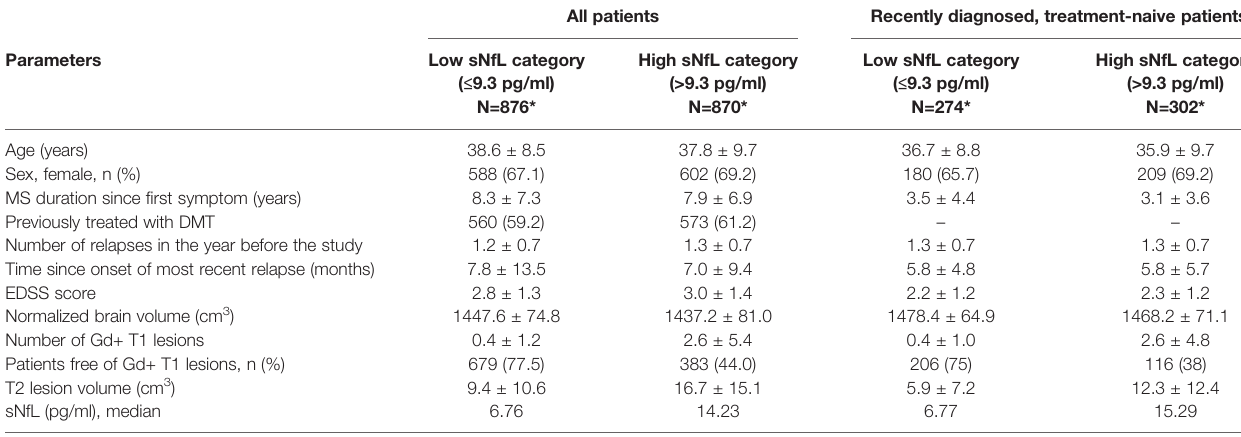
TABLE 1 | Demographics and baseline characteristics in the overall study population, and in the subgroup of recently diagnosed, treatment-naive patients, by sNfL baseline high –